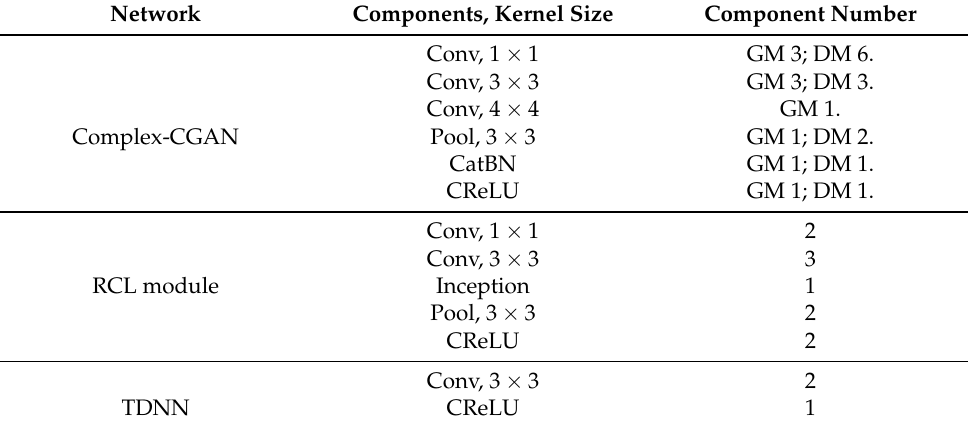
Table 2. Specific network parameter settings for the noise-reduction learning model.